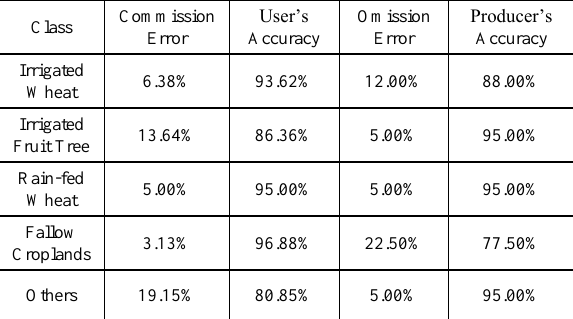
Table 2. Accuracy assessment by ground-truth